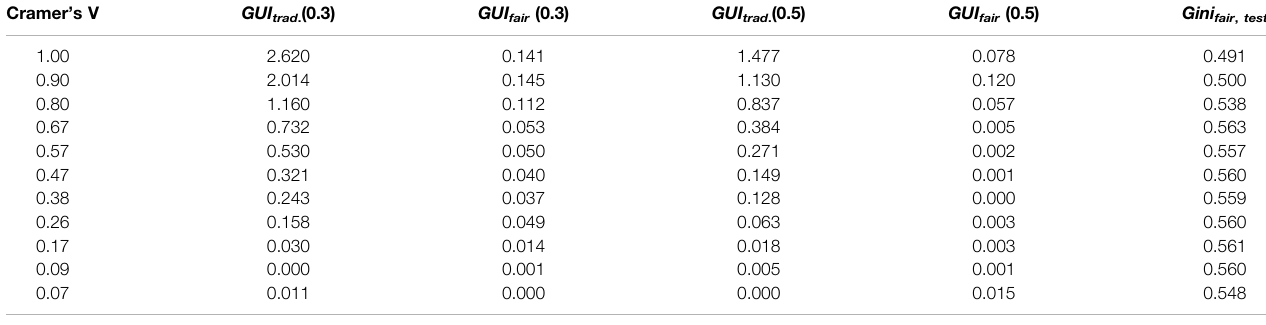
TABLE 7| Results ofthe simulationstudy: Group unfairness index (GUI)of both the traditional aswell as thefair model and performanceon the test data ofthe fairmodel for different levels of dependence (Cramer ’ s V) between the protected attribute and the variable status. Cramer ’ s V GUI trad . (0.3)